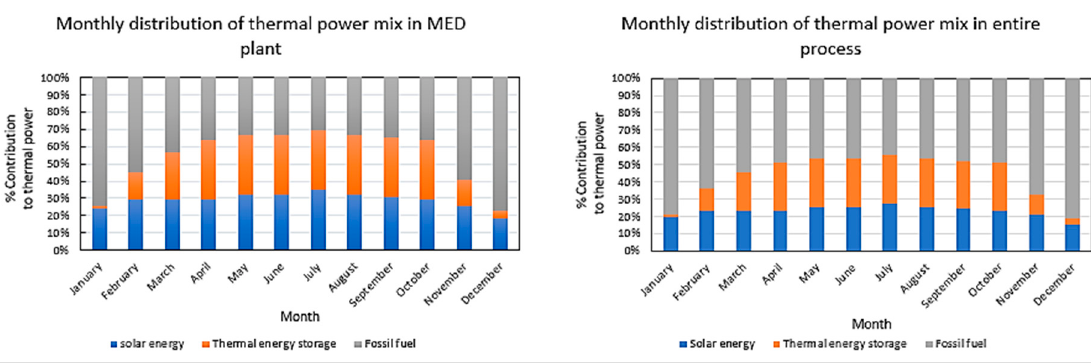
Figure 4. Optimal thermal power mix for MED plant and the entire system with 30% RO 70% MED .